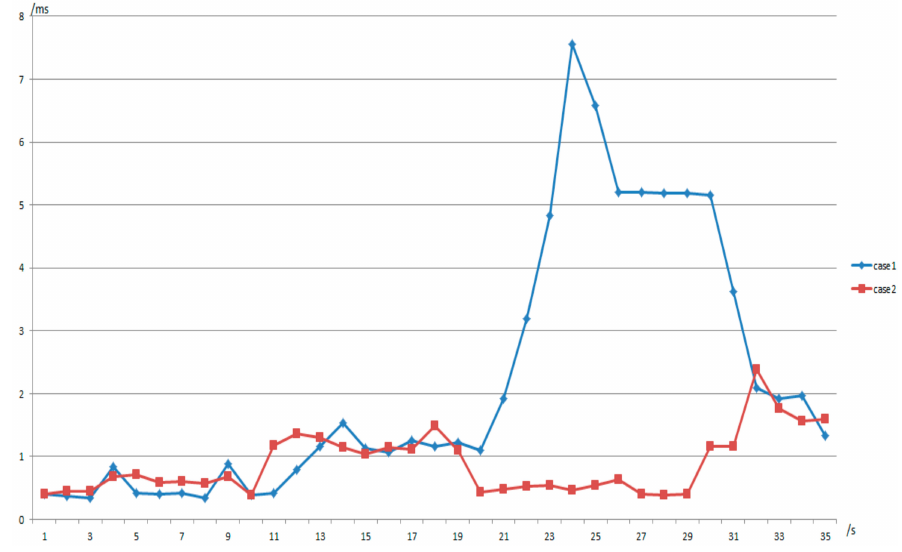
Figure 8. Comparison of the link